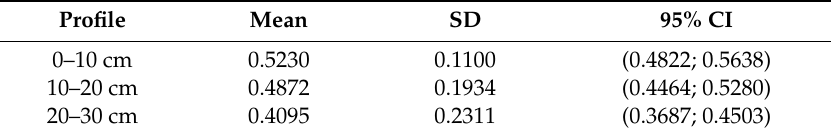
Table 6. Mean value, standard deviation, and confidence interval per sample